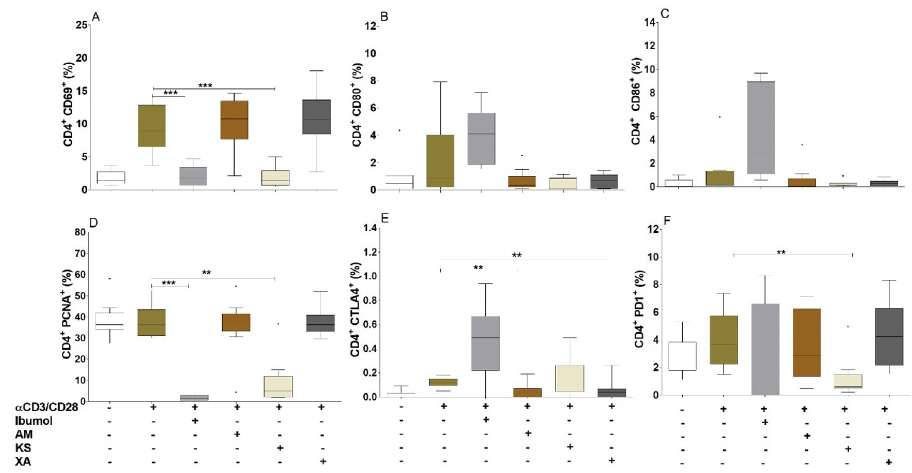
Fig 6. T cells activation and proliferation by Aframomum melegueta , Khaya senegalensis and Xylopia aethiopica hydro-ethanolic extracts. PBMCs (2x10 5 cells) from endemic normal individuals (n = 9) were activated with α CD3/ α CD28 (0.5 beads/ μ l) in the presence or absence of Ibumol, Aframomum melegueta (AM), Khaya senegalensis (KS) or Xylopia aethiopica (XA) (200 μ g / ml) for 24 hours. Thereafter, cells were stained for CD4 in combination with either CD69 (A), CD80 (B), CD86 (C), PCNA (D), CTLA4 (E) or PD1 (F). Graphs show percentages as box whiskers (tukey) with outliers. Asterisks show statistical differences (Mann-Whitney-U test) between the groups indicated by the brackets ( � p < 0.05, �� p < 0.01, ��� p < 0.001); ns (not significant).